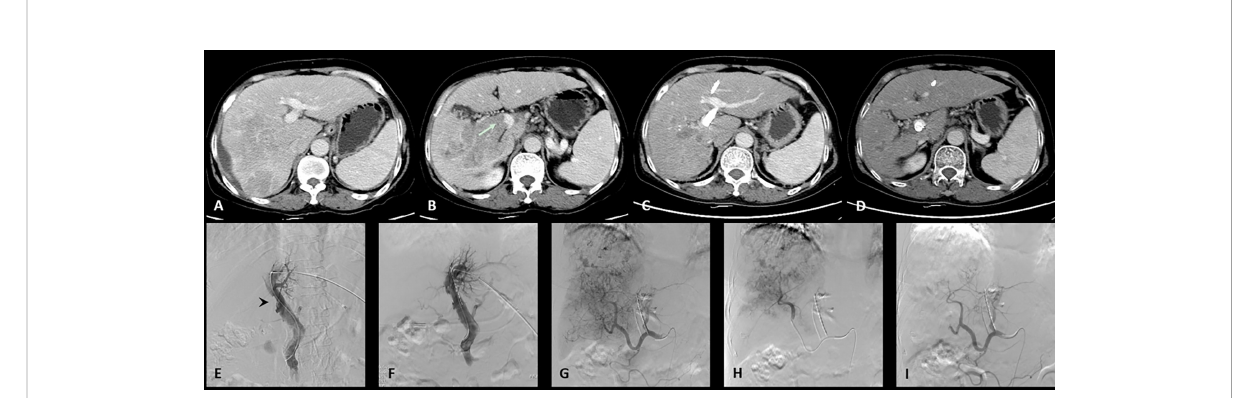
FIGURE 1 One case of the C-TACE group. The patient was a 60 years old female. (A) : Preoperative CT images showed a huge tumor in the right lobe of the liver. (B) : Tumor thrombus (arrow) was seen in the right branch and main portal vein. (C) : After 3 months follow up, the tumor was signi fi cantly reduced. (D) : The patency of portal vein stent was revealed after 3 months follow up. (E) : Filling defect was showed in the main portal vein (arrow head) during venography. (F) : Portal vein stent (diameter: 12 mm, length: 60 mm) was implanted and 12 125I radioactive seeds were used. (G) : Hepatic artery angiography showed large tumor staining of the right lobe of the liver. (H) : Superselective embolization of the tumor artery branches with 50 milligrams of epirubicin mixed with 10 ml lipiodol and 1 box of gelatin sponges was used to enhance embolization. (I) : Angiography after embolization, tumor blood supply was signi fi cantly